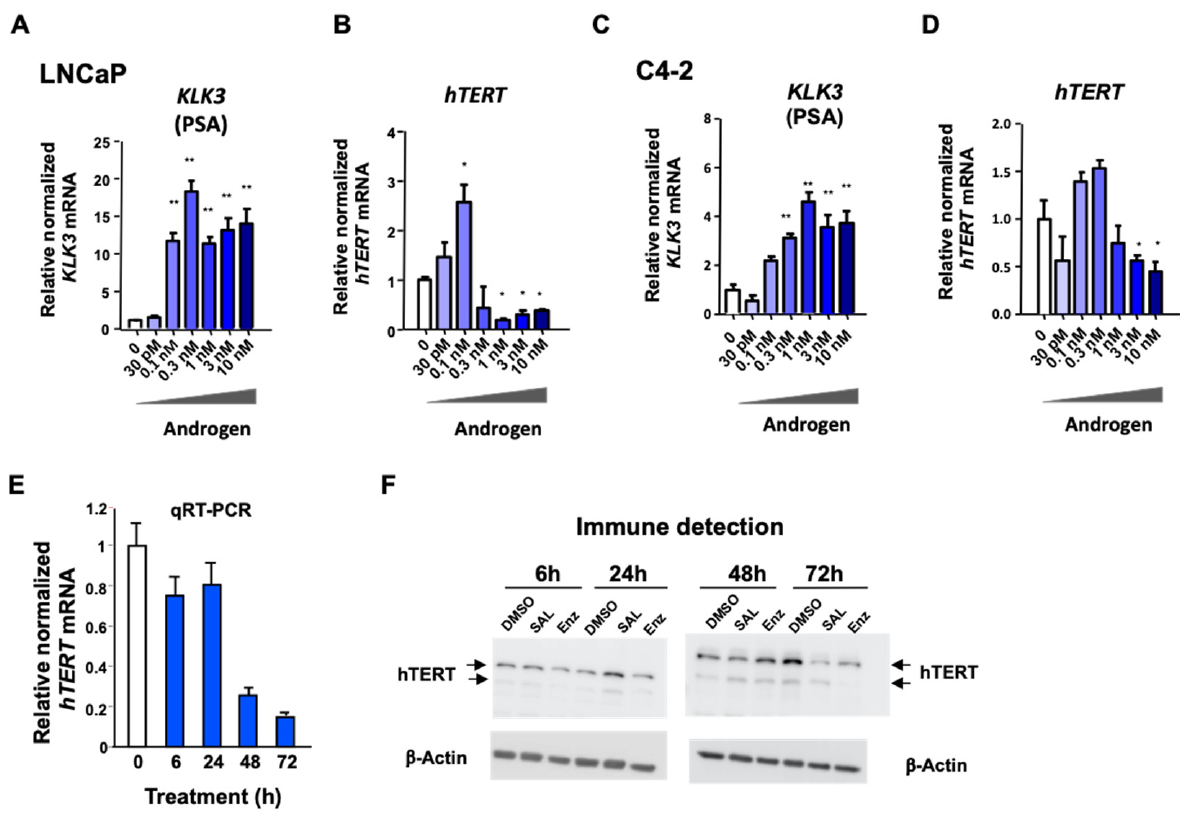
Figure 3. Concentration- and time-dependent response of hTERT expression by androgens. LNCaP ( A , B ) or C4-2 ( C , D ) cells were treated with the indicated concentrations of R1881 for 3 days and were analyzed by qRT-PCR for KLK3 mRNA, encoding PSA, as a positive androgen-responsive gene ( A , C ), or for the hTERT mRNA levels ( B , D ). β -Actin was used for normalization. The values were calculated relative to DMSO, which was set arbitrarily as 1. Error bars indicate SEM. ( E ) hTERT expression was analyzed at an mRNA level by qRT-PCR of LNCaP cells treated for the indicated time periods with 1nM R1881. Indicated are the relative values normalized to house-keeping gene β -Actin and RPL13a. ( F ) Western blotting indicates the protein level of the two hTERT isoforms (arrows) at the indicated treatment times. The treatment with second-generation AR antagonist Enzalutamide (Enz; 10 µ M) was included. β -Actin was used for normalization. DMSO served as the solvent control. p -values: * p ≤ 0.05, ** p ≤ 0.01.